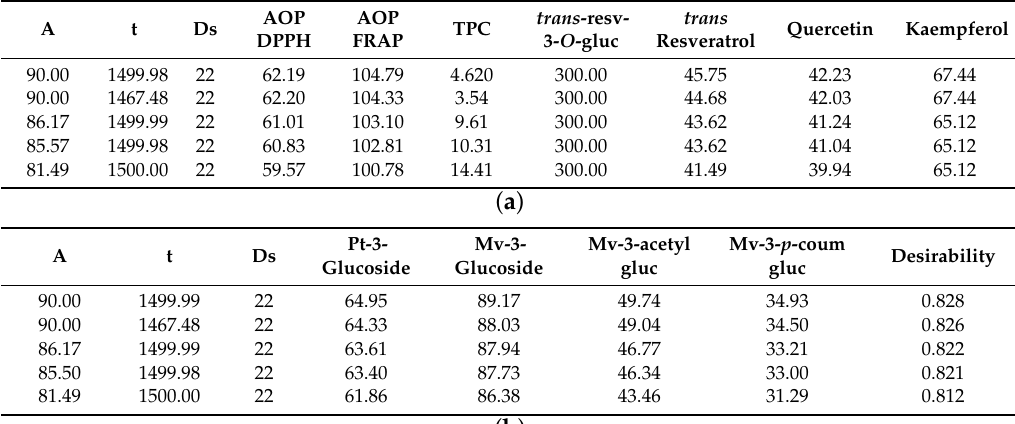
Table 3. The five best optimized conditions of the UA extraction for investigated polyphenolic compounds expressed as a % of increased yields between the UAE and CE for the Vranac variety.